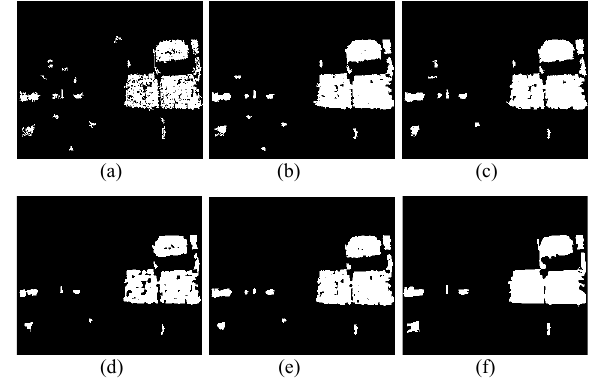
Figure 8. Results of Weishanzhuang dataset: (a) LR-FCM. (b) NR-ELM. (c) GarborPCANet. (d) NAWL. (e) Proposed. (f) Reference image.